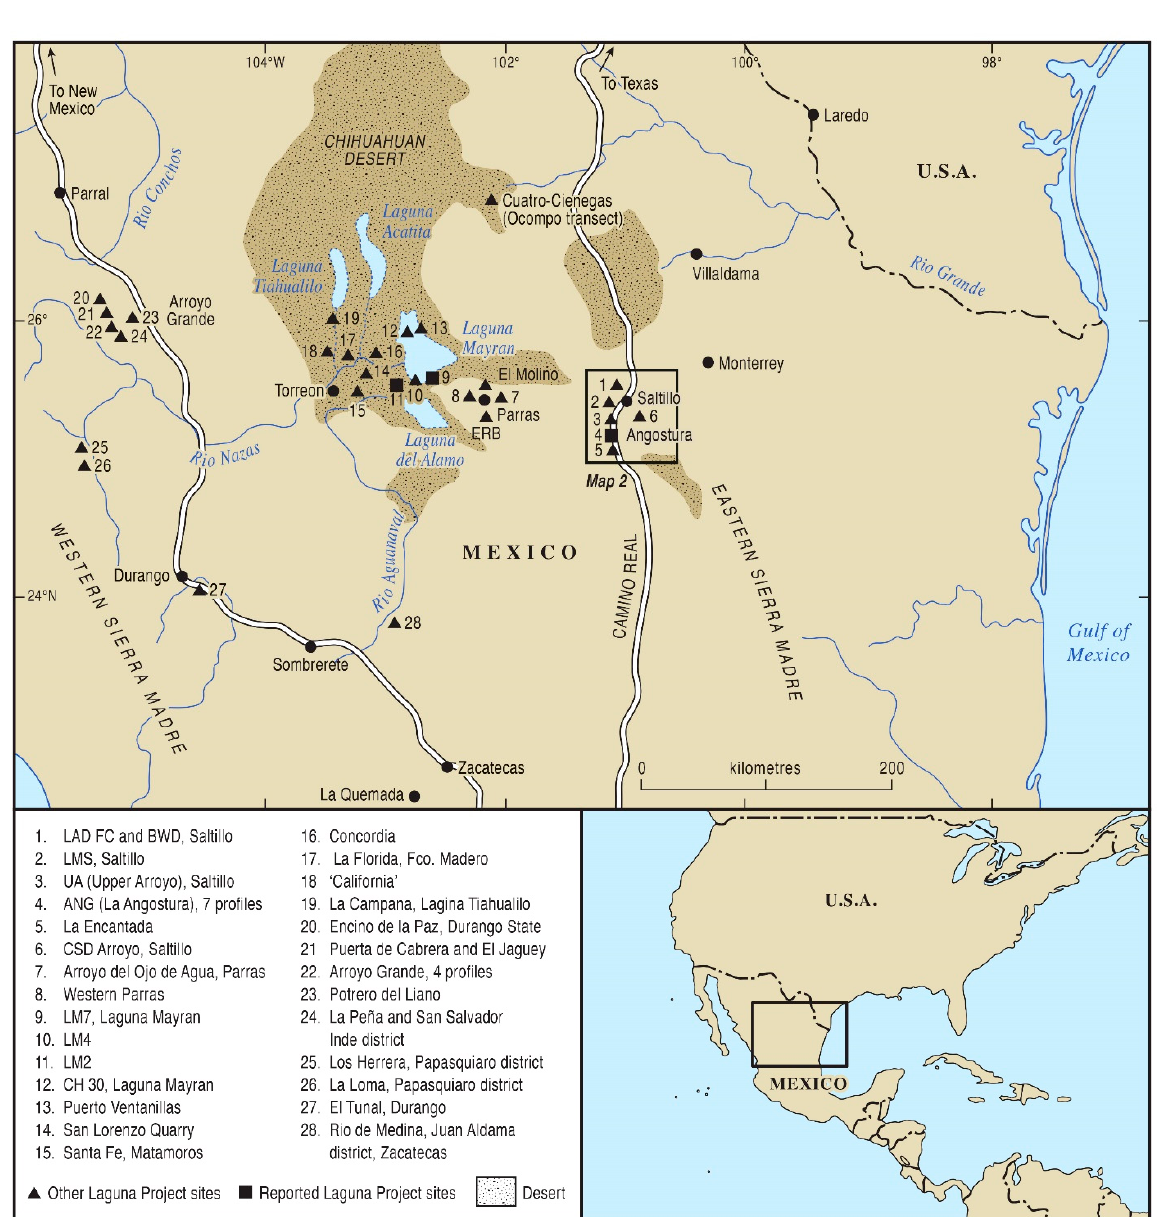
Figure 1. Laguna Project sites (40), northeastern Mexico. These are Upper Arroyo pollen and fluvial; the geomorphic site is indicated (Site 3) within the rectangular inset. These forty sites represent the totality of the geomorphological and botanical data contributing to the cumulative dataset for wet–dry cycles during the last 13,000 years Site 4 (La Angostura) is also mentioned in the main text.